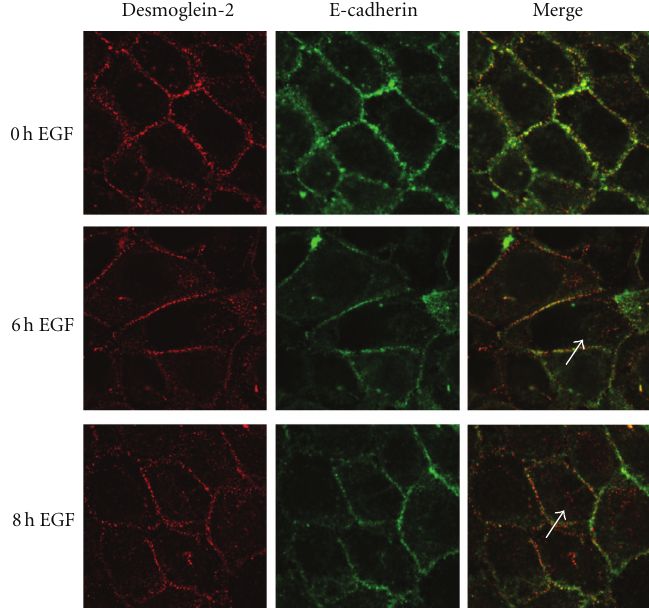
Figure 6: Desmoglein-2 does not internalize with E-cadherin. SCC 12F cells were treated with EGF for the indicated times, fixed, then probed with E-cadherin or desmoglein-2 antibodies. The desmosomal cadherin desmoglein-2 is relocalized from the cell borders at 6–8hrs after EGF treatment. Note punctate cytoplasmic staining (white arrows). This pattern di ff ers from that observed for the adherens junctional cadherin, E-cadherin, where strong border staining is evident at 6 hours post EGF treatment.